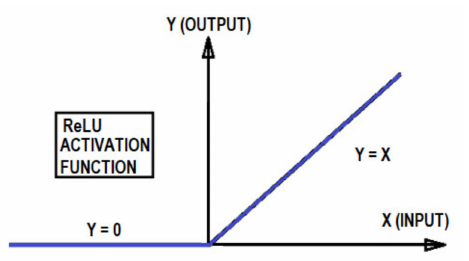
Figure 11. ReLU activation function.